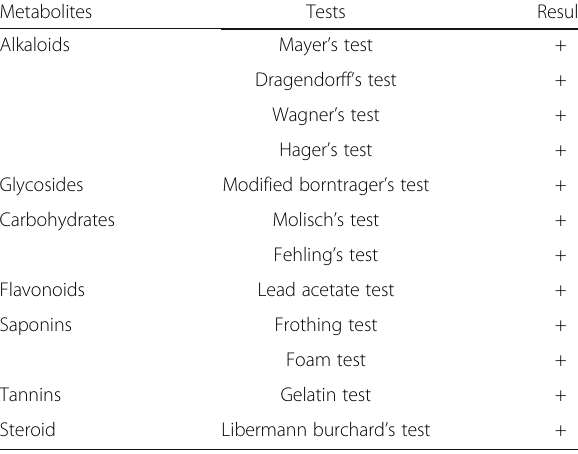
Table 1 Results of different chemical group test of the MESC Metabolites